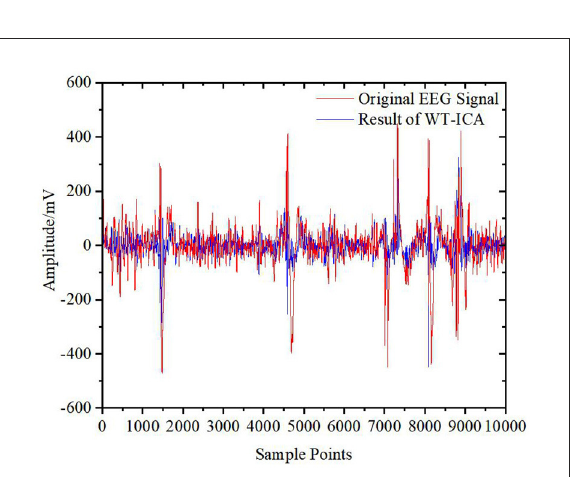
FIGURE12 Raw EEG signal and result of